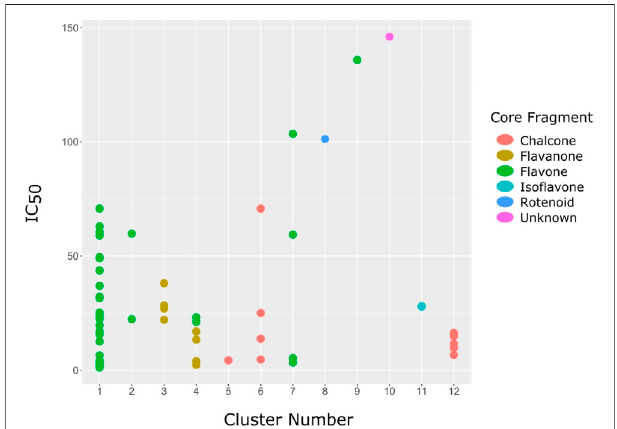
FIGURE 3 | The graph showing the distribution of IC 50 values for compounds in each cluster. The graph shows that each cluster contain one distinct core fragment, with the exception of Cluster 4, which contains both Flavone and Flavanone. Flavanone and Chalcone showed the obvious correlation between structure and bioactivity. Flavanones in Cluster 4 contain sugar moieties but is absent in Flavanones in Cluster 3, and the IC 50 values of both clusters do not